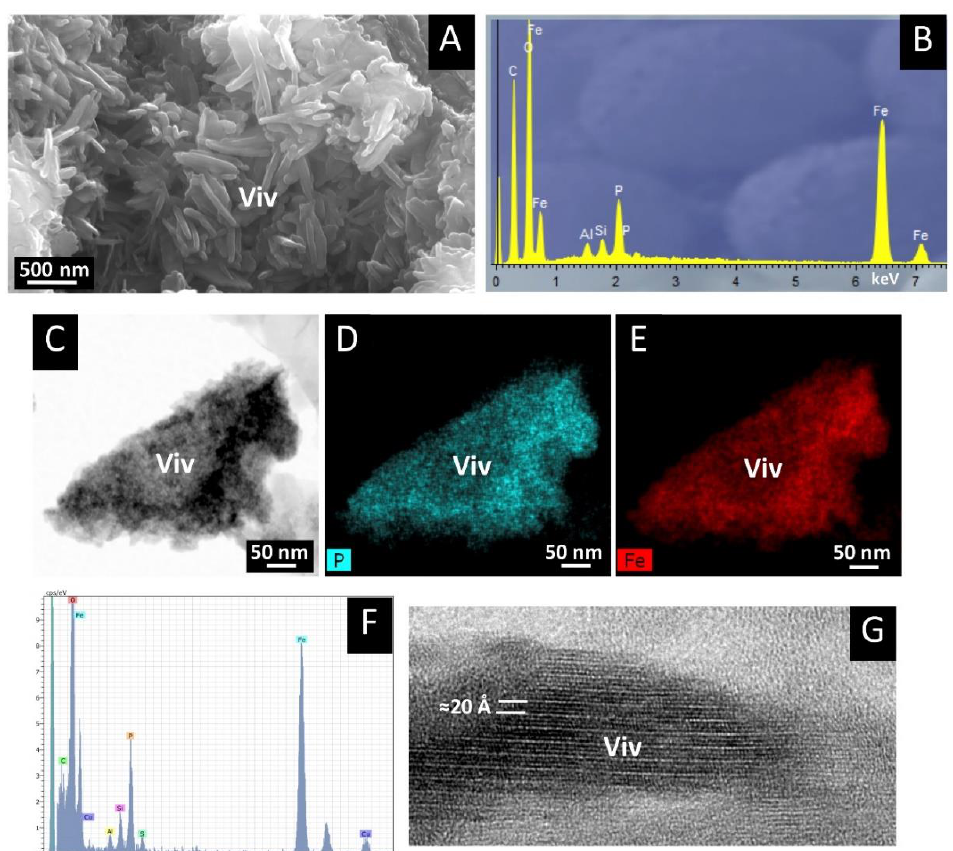
Figure 4. FESEM, HRTEM and EDX images of vivianite from permanently flooded sediments of La Playa dam (sample LP7): ( A ) prismatic to flat nanocrystals of vivianite frequently associated with the occurrence of plant fragments (SE image); ( B ) FESEM-EDX spectrum of vivianite from ( A ); and ( C ) HRTEM image (bright field) of a vivianite crystal; ( D ) elemental map (HRTEM-EDX) of P (image c); ( E ) elemental map (HRTEM-EDX) of Fe (image c); ( F ) HRTEM-EDX spectrum of vivianite; ( G ) lattice fringe image of vivianite crystal from image ( C ). Viv: vivianite. Goethite was only identified in the XRD patterns of the periodically emerged sedi- ments by a small peak at 4.18 Å and a peak at 2.46 Å over-imposed to clays (Figure 2B). The SEM images revealed that goethite occurs as crusts with dendritic and botryoidal morphologies in the silicate-rich bands of the sediments (Figure 5).